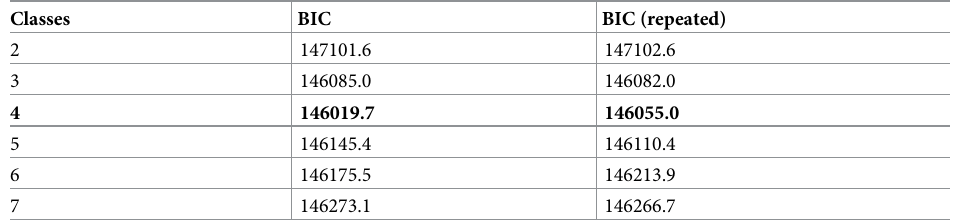
Table 2. LCA model optimization. Note that BIC is minimized with 4 classes.